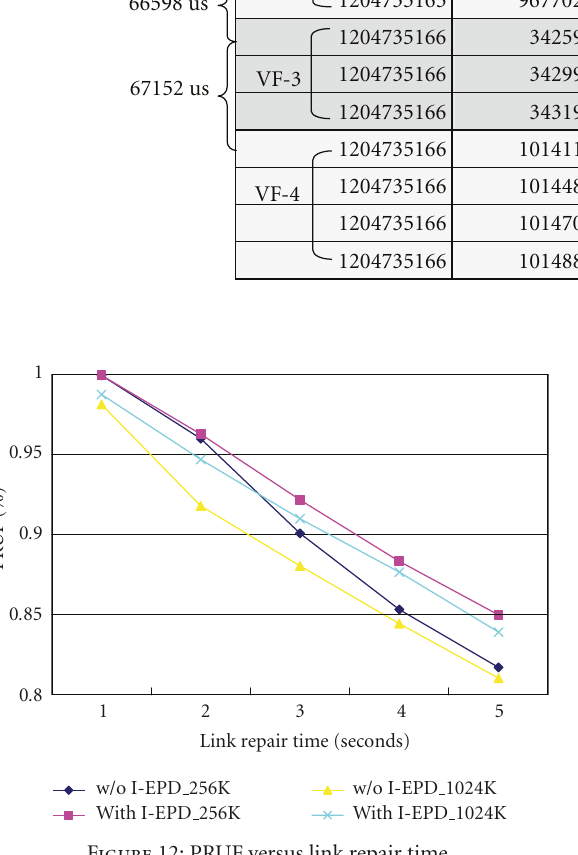
Figure 12: PRUF versus link repair time.